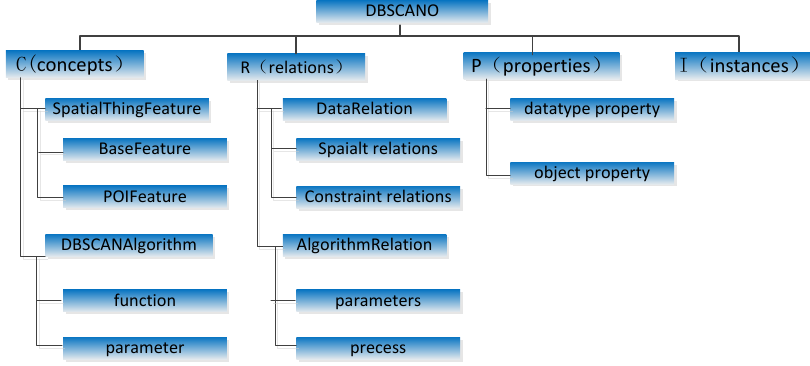
Figure 5. Structural of DBSCANO ( DBSCAN ontology).